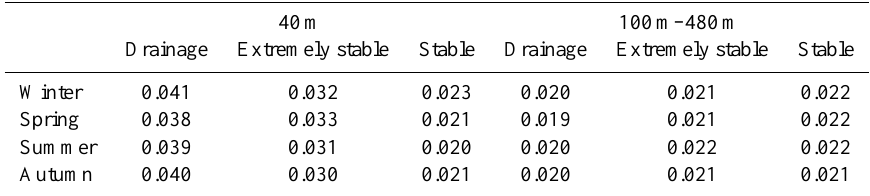
Table 3. Brunt-V¨ais¨al¨a frequency (s − 1 ) medians during the night under different stability